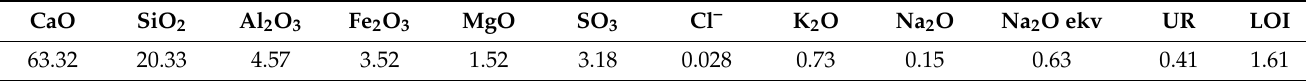
Table 2. Phase composition in wt.% of used cement. Determined by the mean XRD. The meaning of the abbreviations used: C 3 S—tricalcium silicate, C 2 S—dicalcium silicate, C 3 A tricalcium